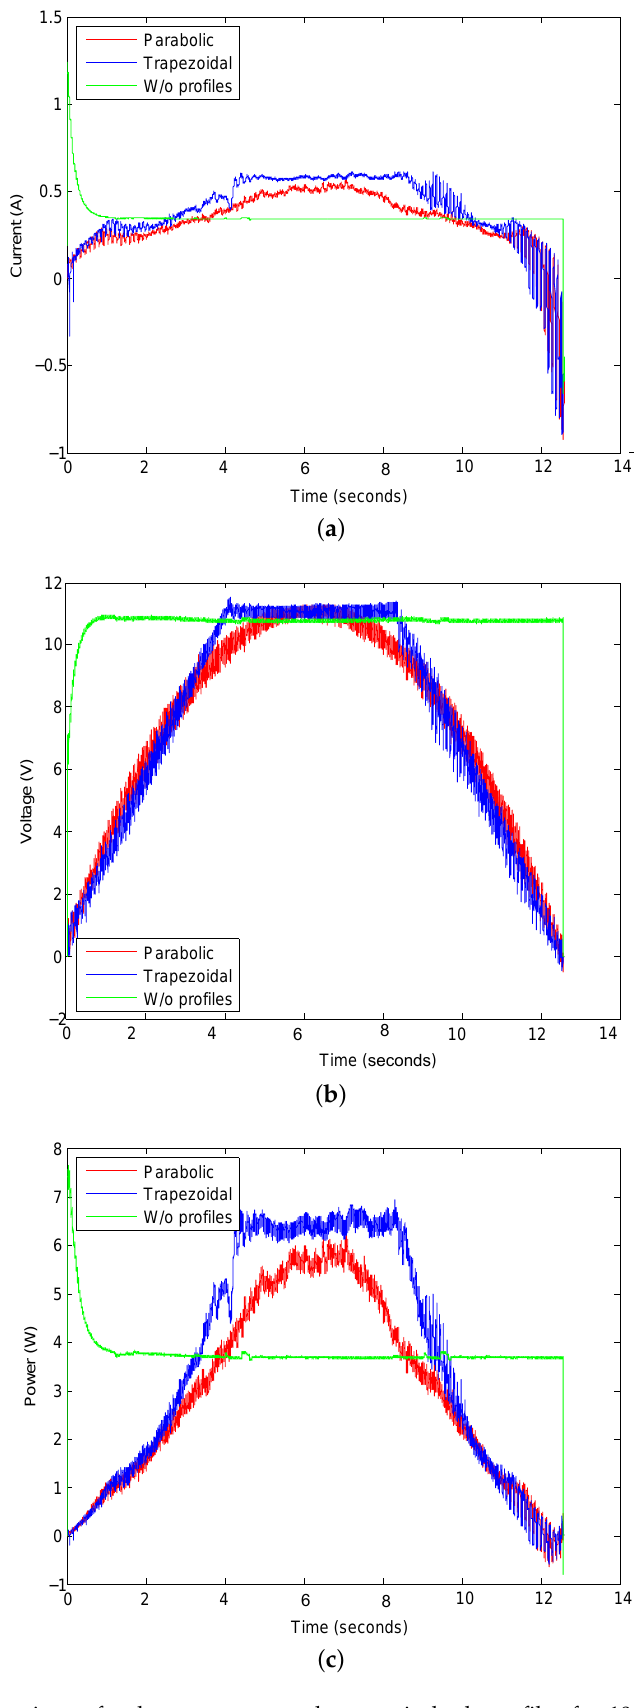
Figure 11. Comparison of voltage, current and power in both profiles for 10 turns. ( a ) Current. ( b ) Voltage. ( c )